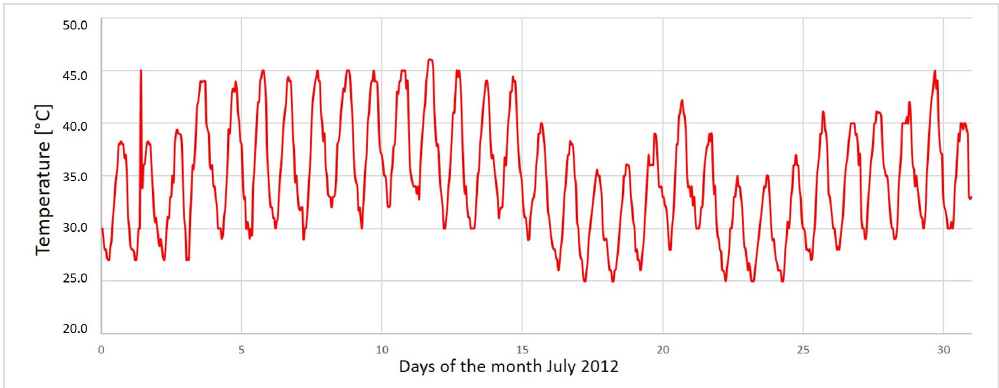
Figure 7. Hourly temperature in Segdoud during the month of July 2012 (National Institute of Meteorology).